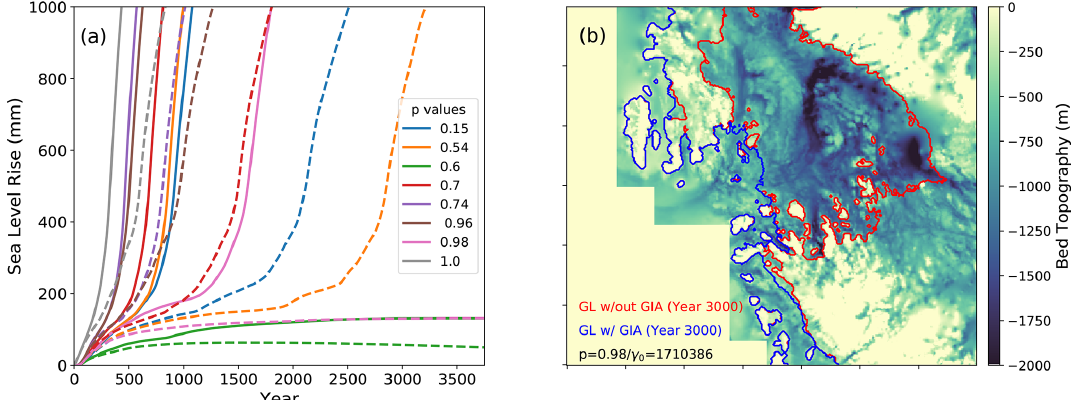
Figure 15. (a) Sea level rise for eight extended simulations with (dashed lines) and without (solid lines) a GIA model. The y axis is truncated at 1m sea level rise to emphasize GIA-related delays of several centuries. (b) Amundsen region grounding line location evolution over the 2 ◦ C synthetic run for p = 0 . 98 /γ 0 = 1710386 without GIA (red) and with GIA (blue) after 3000 years of simulation time. The shaded background shows seafloor topography (m) without isostatic adjustment. Negative values indicate a bed below sea